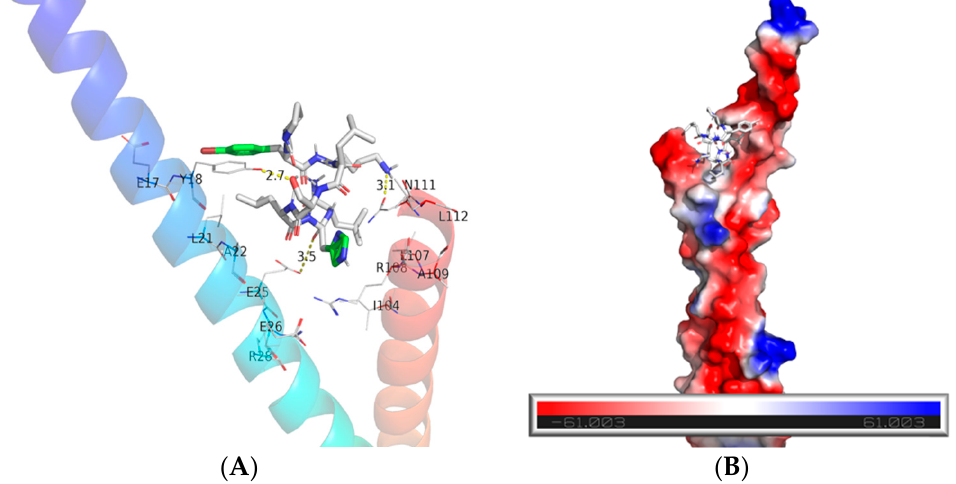
Figure 3. Molecular modeling of Br-J-I binding to potential target FadA. ( A ) Br-J-I interacts with the tail region of antiparallel α -helices of FadA (PDB: 3ETW) with the three potential hydrogen bonds shown in yellow dashed lines (distance labeled in Å). For clarity, only the protein segments that contain the groups of interest are shown. FadA is shown in an α -carbon rainbow cartoon from blue in N-terminus to Red in C-terminus. The potential interfacial residues for Br-J-I in FadA are shown in lines and Br-J-I are in sticks. N, O, and C atoms of side chains are colored blue, red and gray, respectively. Aromatic ring is in green and Br is in orange. ( B ) Surface representation of FadA illustrating the Br-J-I binding pocket. Hydrophobic, positively charged, and negatively charged surfaces are colored gray, blue, and red, respectively. Molecular docking was carried out by Vina docking software, and the interactions between ligand and receptor were analyzed and presented by PyMOL.